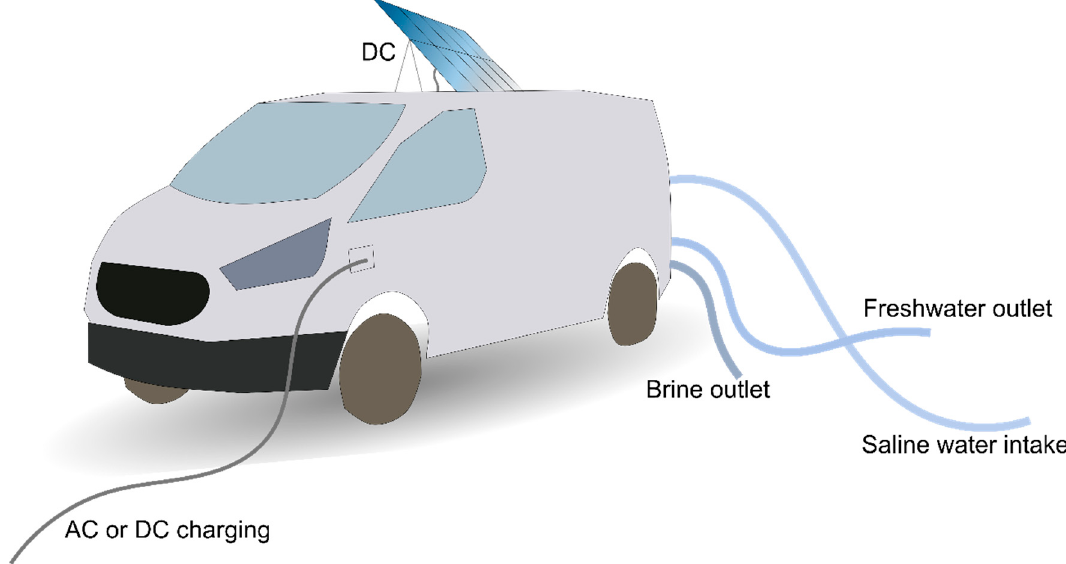
Figure 1. An electric van with AC or DC charging, solar panels on the roof generating DC, and an RO desalination system inside for a mobile freshwater production system. Inlet of saline water and outlet of freshwater and brine are shown in the sketch.